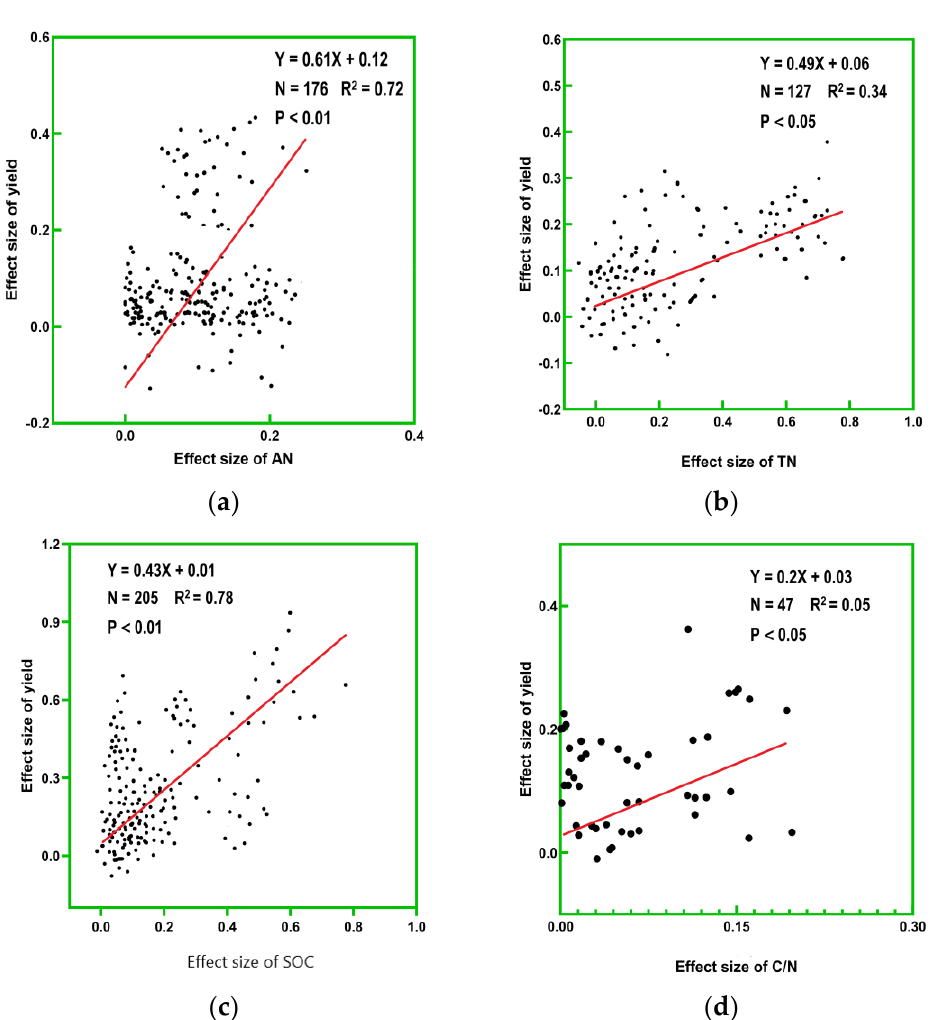
Figure 12. Correlation between yield effect value and ( a ) soil AN, ( b ) soil TN, ( c ) SOC, and ( d ) the C:N ratio effect values under total straw return. Description of symbols: AN, soil alkaline-hydrolysable nitrogen; TN, soil total nitrogen; SOC, soil organic matter; C:N, the soil carbon–nitrogen ratio.